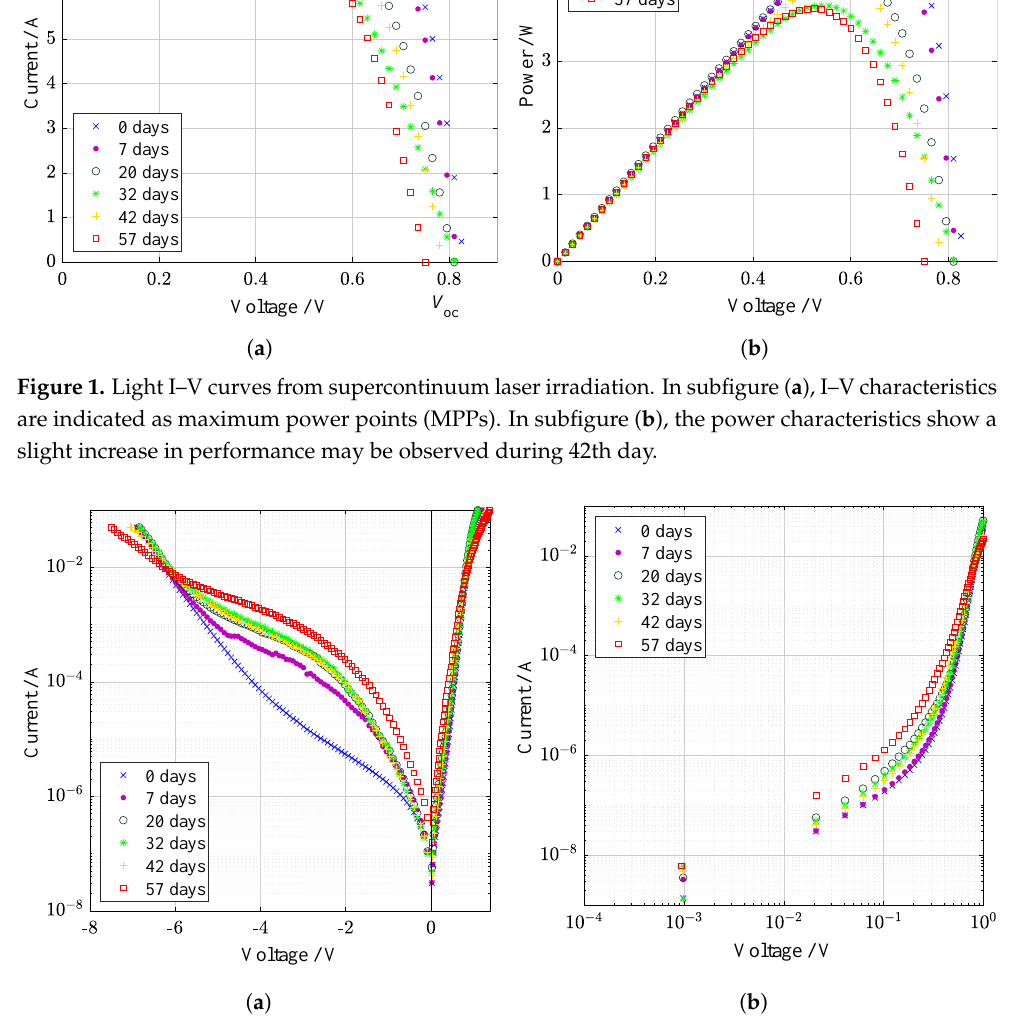
Figure 2. Dark I–V curves from supercontinuum laser irradiation in ( a ) semi-logarithmic and ( b ) log- log scale. Slight relaxation and improvement during 20 to 42th day is